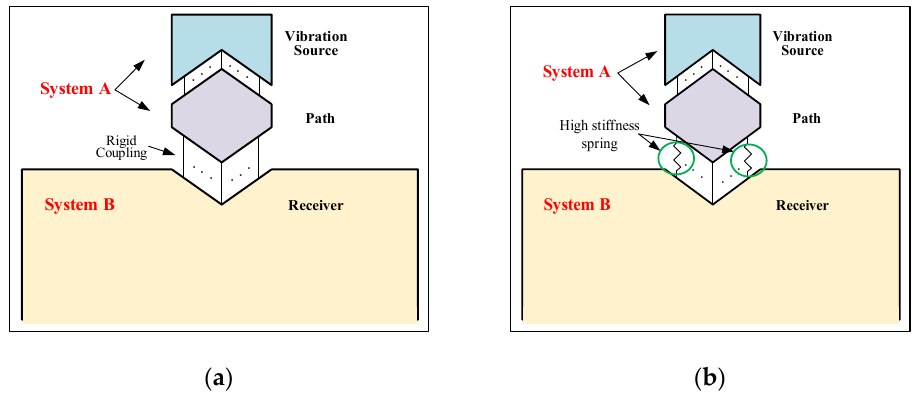
Figure 2. Schematic diagram of project example model: ( a ) Use rigid connection; ( b ) Use high-stiffness spring instead of connection.